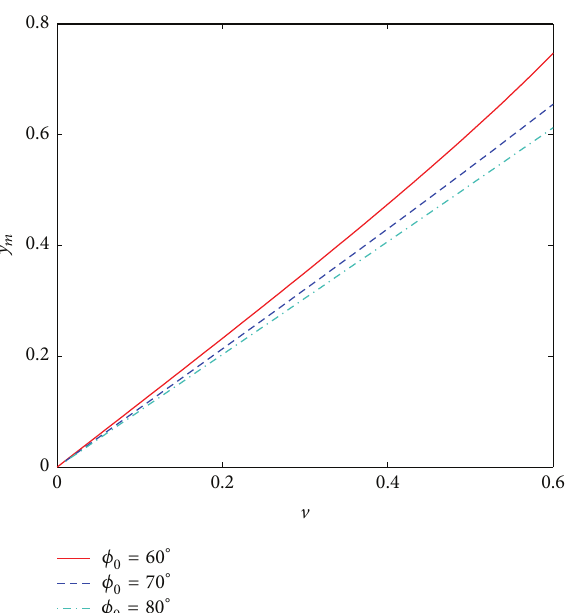
Figure 4: Maximum response nondimensional displacement of the system when the suspension angle 𝜙 0 = 60 ∘ , 70 ∘ , 80 ∘ .